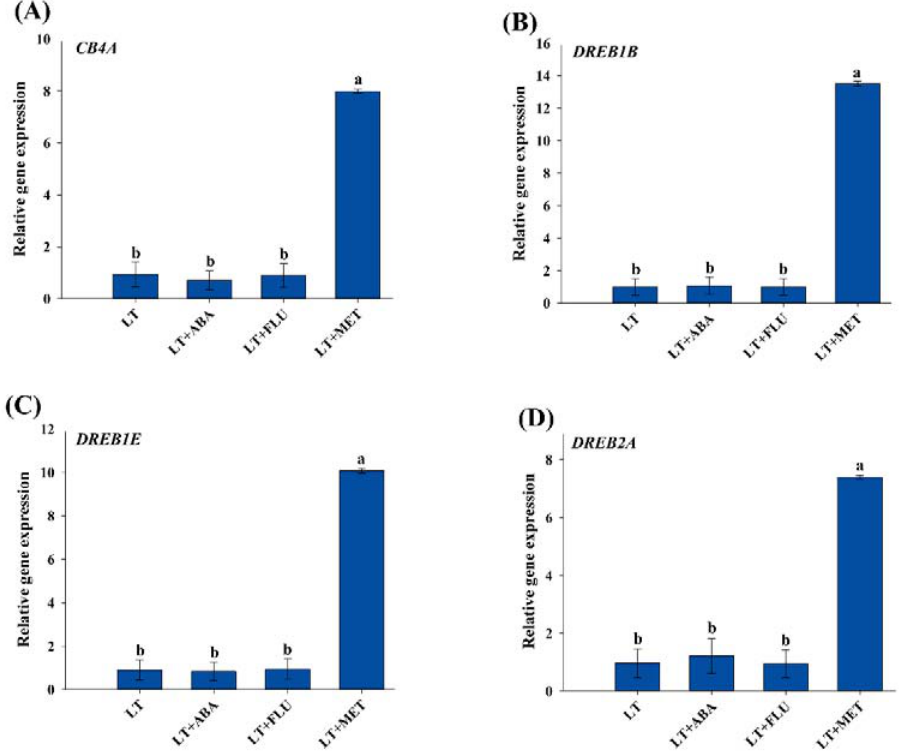
Figure 9. Effects of exogenous melatonin and ABA treatment on cold-related genes; transcript levels of CBF4A ( A ), DREB1B ( B ), DREB1E ( C ), and DREB2A ( D ) in strawberry seedlings under cold stress. The strawberry seedlings were pretreated with distilled water (LT), 100 µ M ABA (LT + ABA), 50 µ M fluridone (LT + FLU), 100 µ M melatonin (LT + MET), and 50 µ M fluridone + 100 µ M melatonin (LT + FLU + MET) 3 times in a two-day interval and then exposed to cold stress for 2 days. Graphs represent the mean of three biological replicates. Values labeled with different letters indicate significant differences among treatments at ( p ≤ 0.05) by